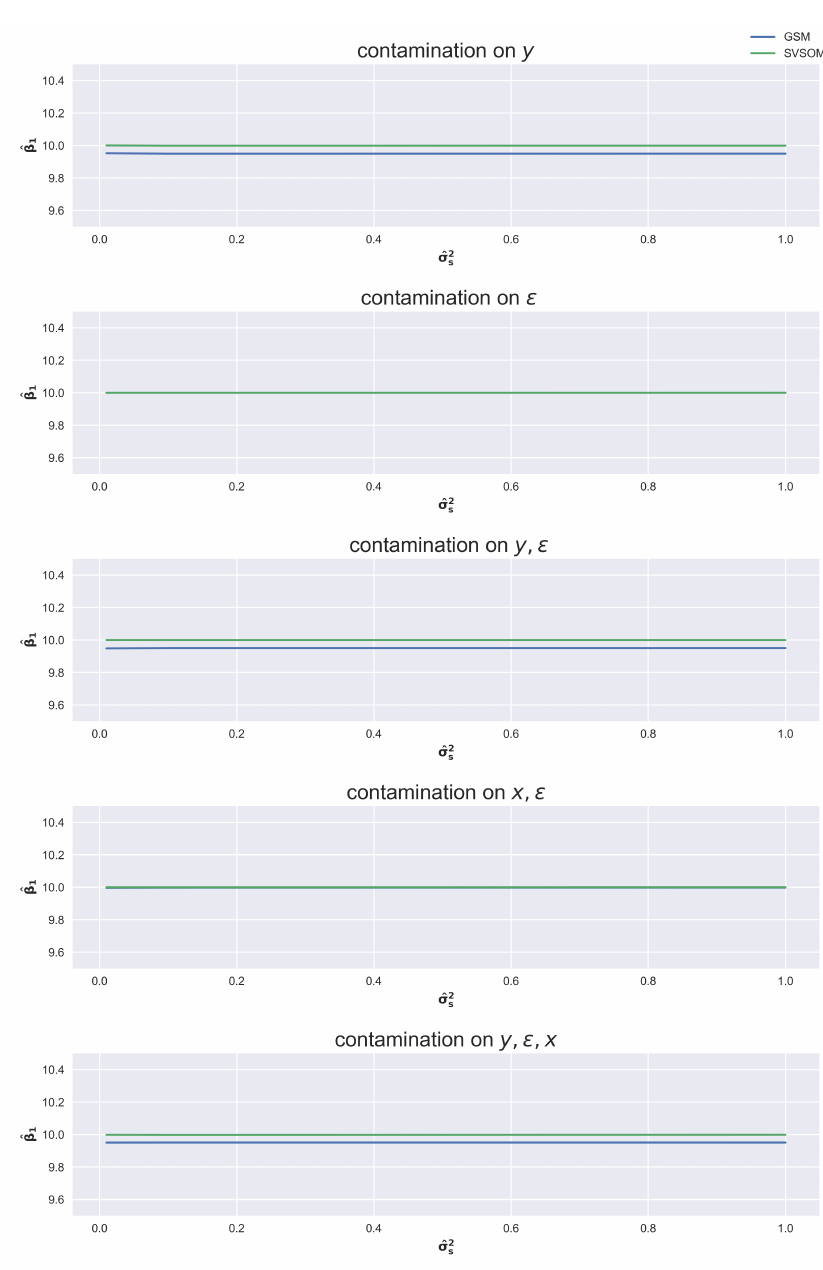
Figure 1. The graph of ˆ σ 2 s against ˆ β 1 for ρ = 0.4 and λ = 0.5 from different sources of